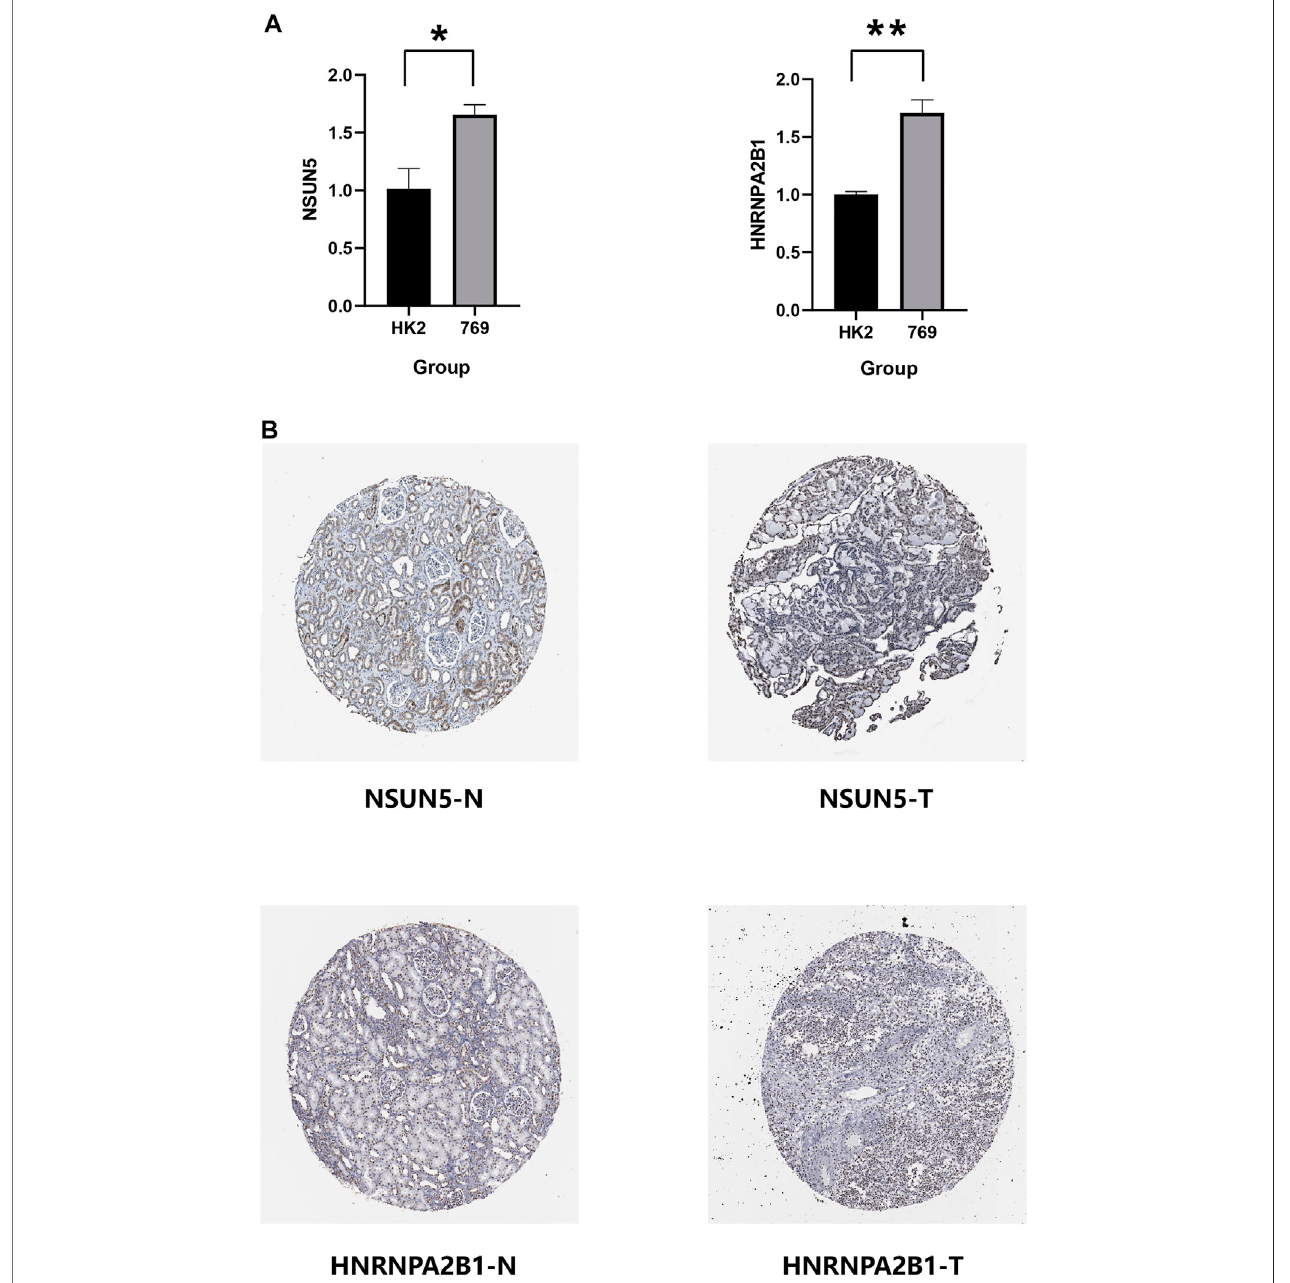
FIGURE11| ExpressionlevelofNSUN5andHNRNPA2B1inrenalclearcellcarcinoma(KIRC) .(A) TheexpressionofNSUN5andHNRNPA2B1inccRCCcelllines (HK2,769) was detected by the qRT-PCR assay. * p < 0.05, ** p < 0.01, *** p < 0.001, and **** p < 0.0001. (B) Protein expression of NSUN5 and HNRNPA2B1 in KIRC. KIRC, kidney renal clear cell